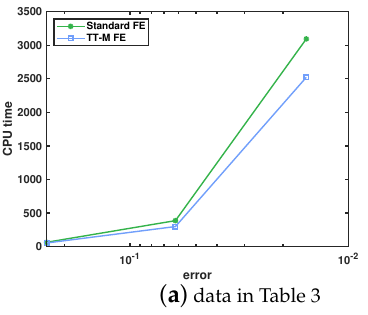
( c ) Space error results in Table 5 Figure 7. Performances of errors in log scale based on the data calculated in Tables 3–6.